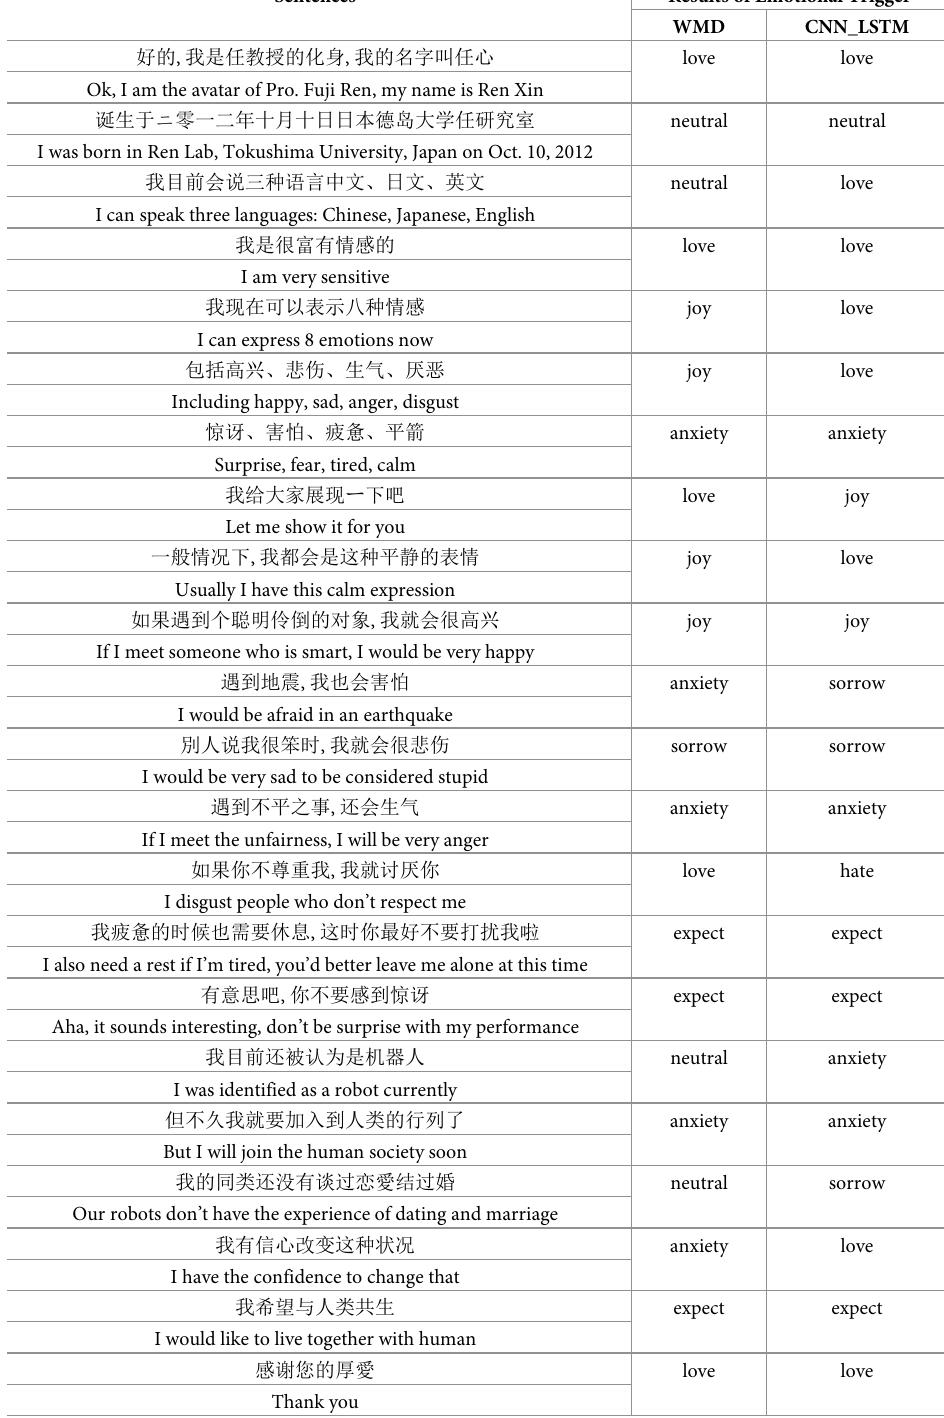
Table 4. Script used in real time demonstration. Sentences Results of Emotional